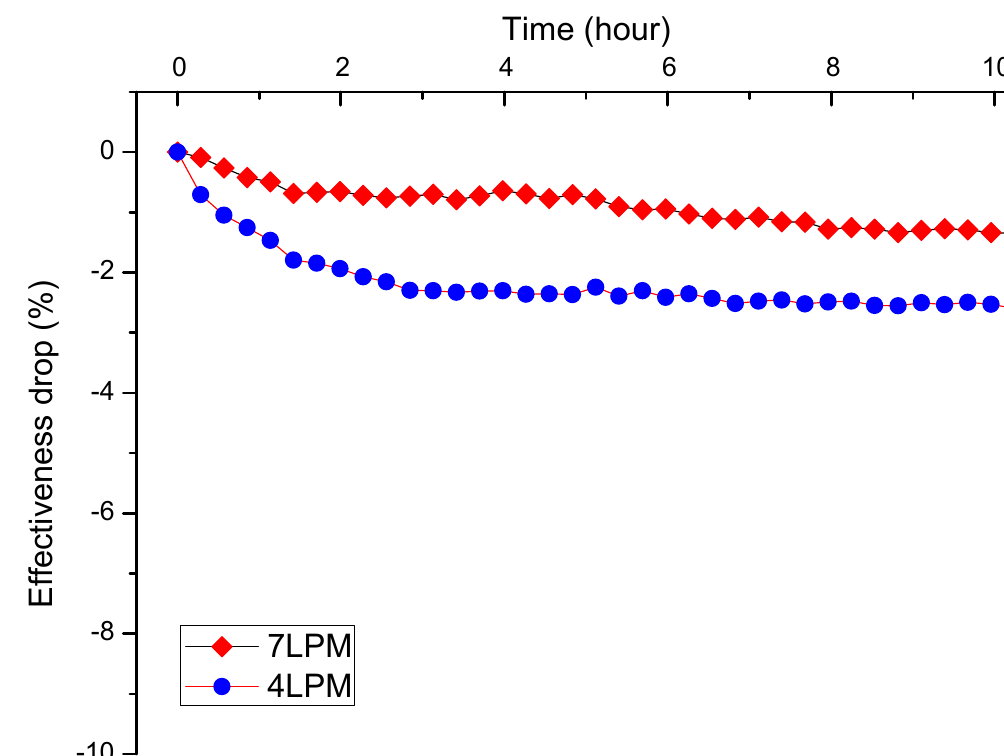
Figure 3. Decline in effectiveness over course of 10 h with respect to various coolant temperatures. EGR inlet gas temperature: 450 ◦ C, mean particle size: 128 nm, and EGR gas flow rate: 4 sLPM.